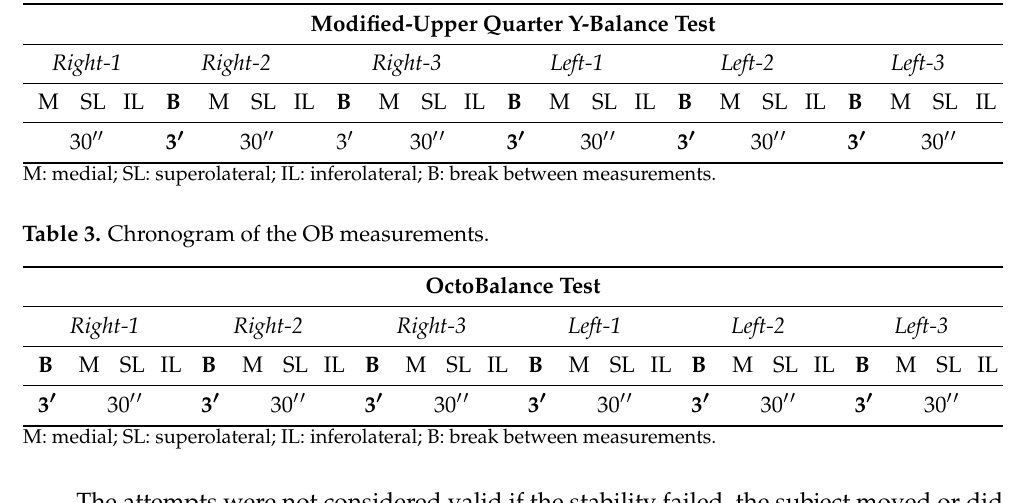
Table 2. Chronogram of the mUQYBT measurements.